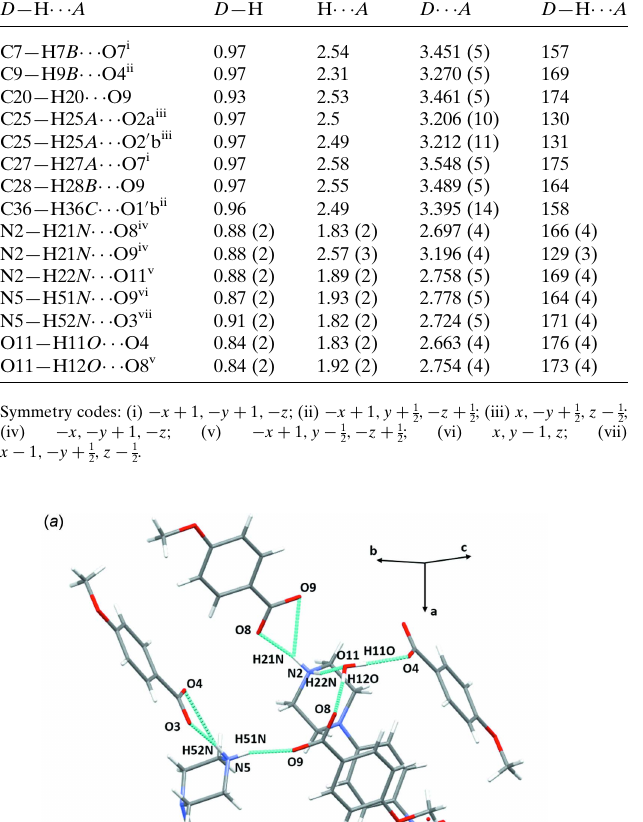
Table 5 Hydrogen-bond geometry (A˚ , (cid:5) ) for (V).